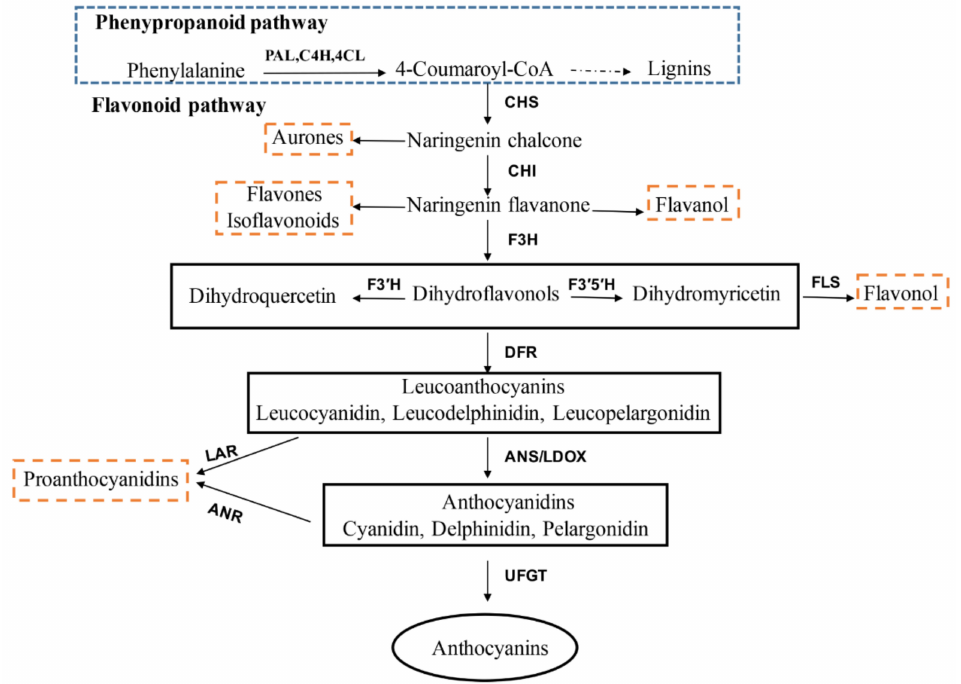
Figure 1. Simplified scheme of the anthocyanin biosynthesis pathway. PAL, phenylalanine ammonia- lyase, C4H, cinnamate 4-hydroxylase, 4CL, 4-coumarate CoA ligase, CHS, chalcone synthase, CHI, chalcone isomerase, F3H, flavanone 3-hydoxylase, DFR, dihydroflavonol 4-reductase, ANS, antho- cyanidin synthase, also called leucoanthocyanidin dioxygenase, LDOX, LAR, leucoanthocyanidin reductase, ANR, anthocyanidin reductase. UFGT, flavonoid